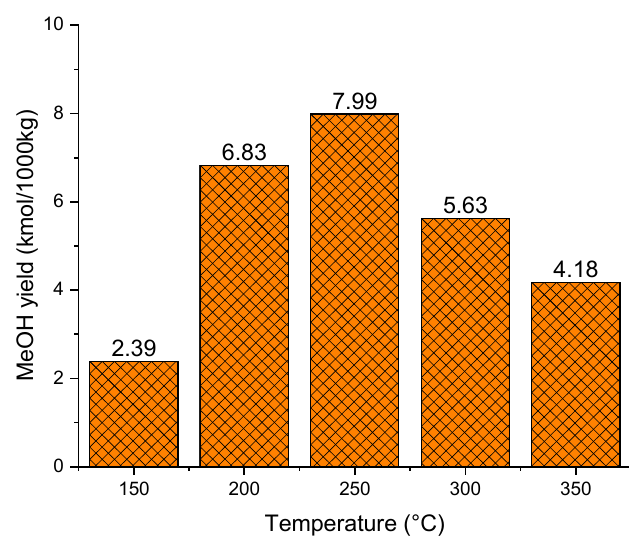
Figure 10. Effect of temperature on methanol yield (50 bar).